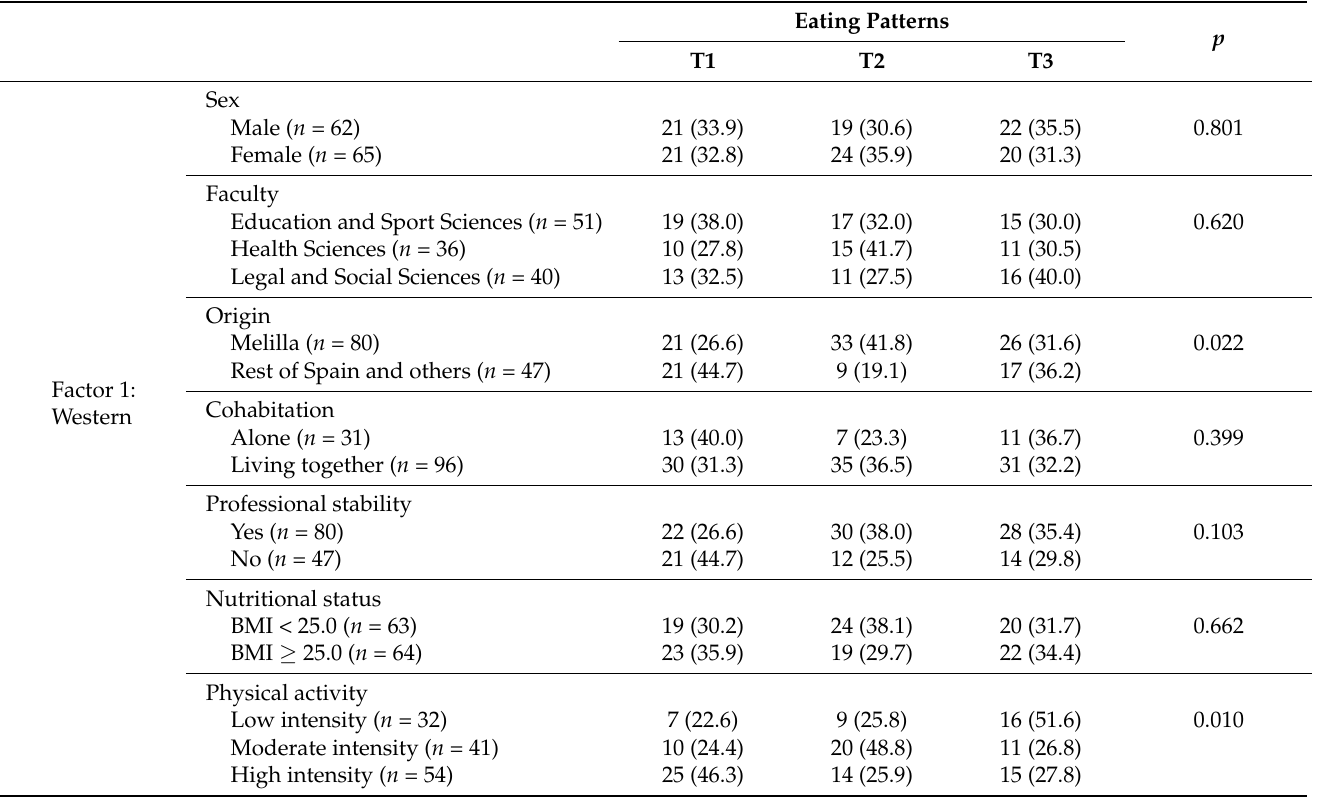
Table 4. Distribution of university professors according to their adherence to the Western eating pattern (by tertiles), sex, centre, origin, marital status, professional stability, nutritional status, and physical activity.